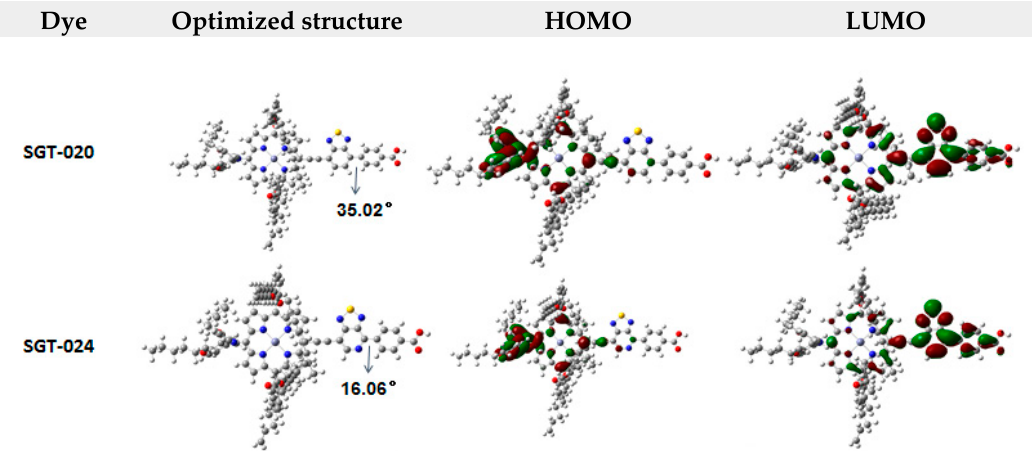
Figure 3. Optimized molecular geometries and electron distributions of the HOMO and LUMO energy levels of SGT-020 and SGT-024 .